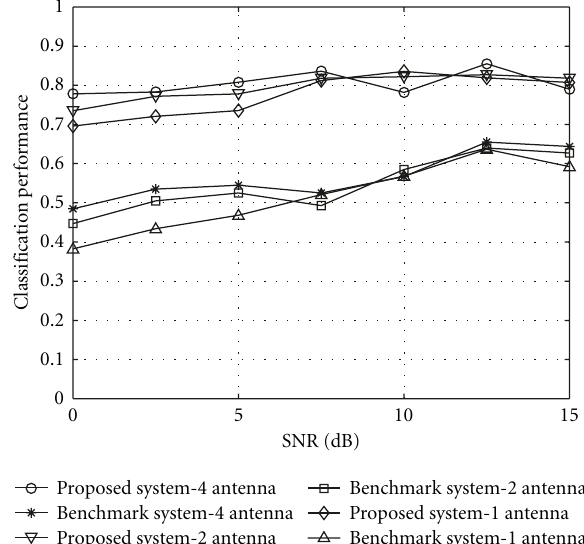
Figure 16: Ability of proposed classifier and benchmark to determine a signal’s modulation family in a slow two-path fading channel using SC.